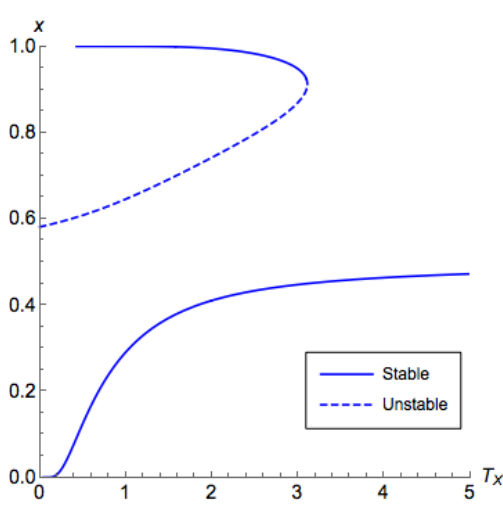
Figure 4. Bifurcation diagram for a coordination game with a Y < b Y and a low T y . The horizontal axis corresponds to the temperature T x for the first (row) player and the vertical axis corresponds to the probability that the first player chooses the first action in equilibrium. We can find that the principal branch is contained in x < 0.5.